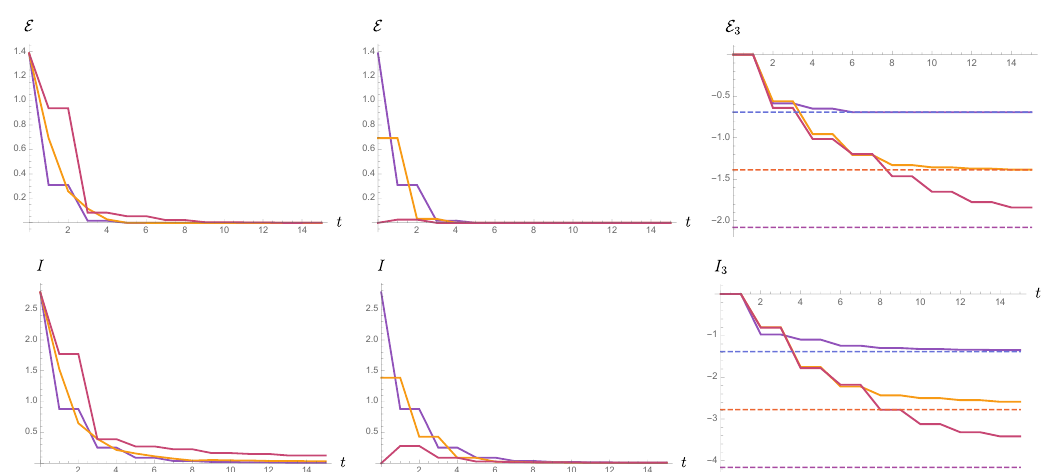
Figure 18 . The operator entanglement for a random unitary circuit with seven input and output spins. The divergence from the line-tension picture from (2.2) can be attributed to (cid:12)nite size and (cid:12)nite q ( q = 2) and size e(cid:11)ects. We use the same con(cid:12)gurations as (cid:12)gure